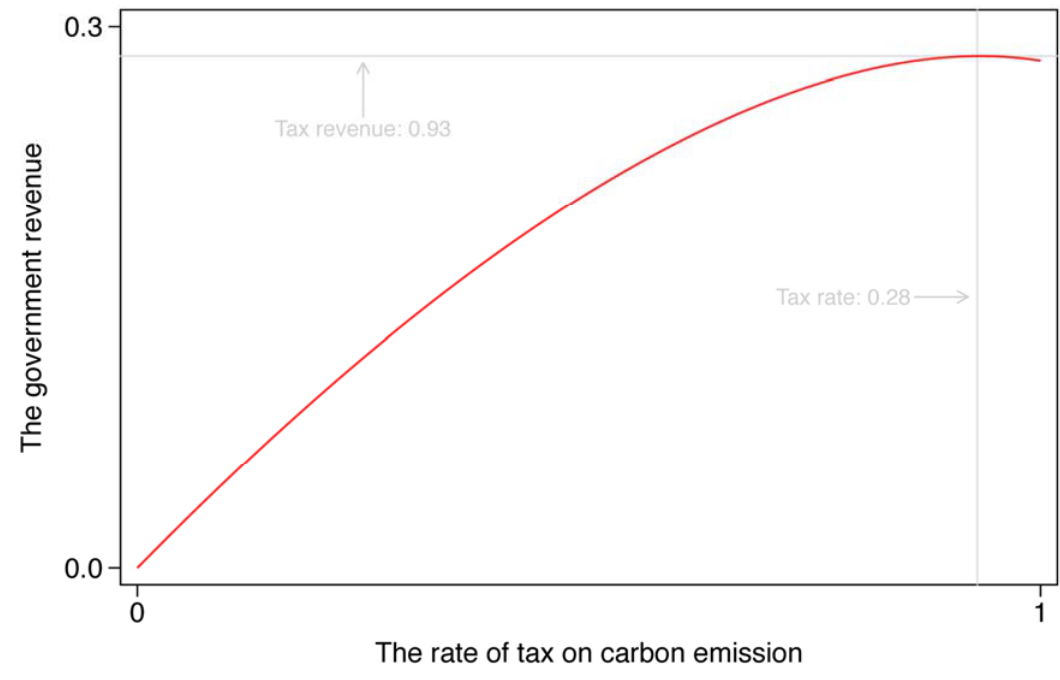
Figure 2. The Laffer curve.